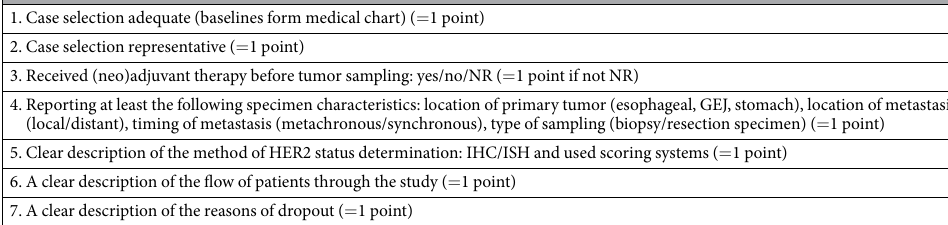
and the remaining determined HER2 status discordance by means of IHC. Seventeen articles included cases with the primary tumor located in the stomach or GEJ, six studies contained data of cases with the primary tumor solely in the esophagus and one study showed data of tumors located either in the esophagus, GEJ or stomach. The majority of studies analyzed adenocarcinomas. Squamous cell carcinomas were analyzed in four articles; all of these cases were analyzed separately from the adenocarcinoma group. Most of the studies (n = 17) focused on discordant HER2 status of synchronous locoregional lymph nodes in resection specimen. Six studies included distant metastases only, five studies showed data of both locoregional lymph node and distant metastases. The